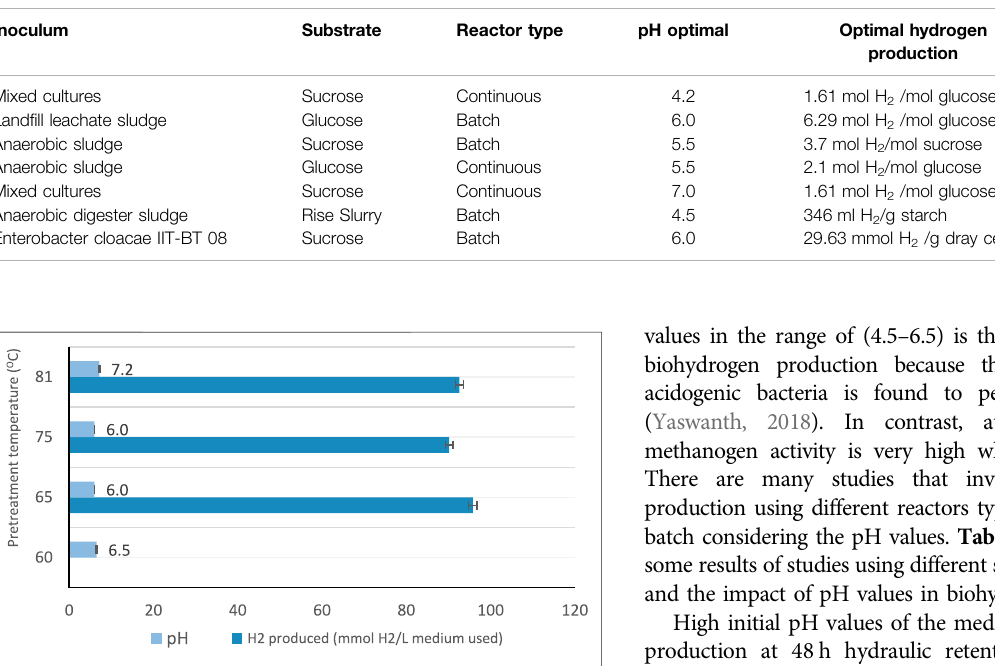
TABLE 4 | The impact of pH values in biohydrogen production.